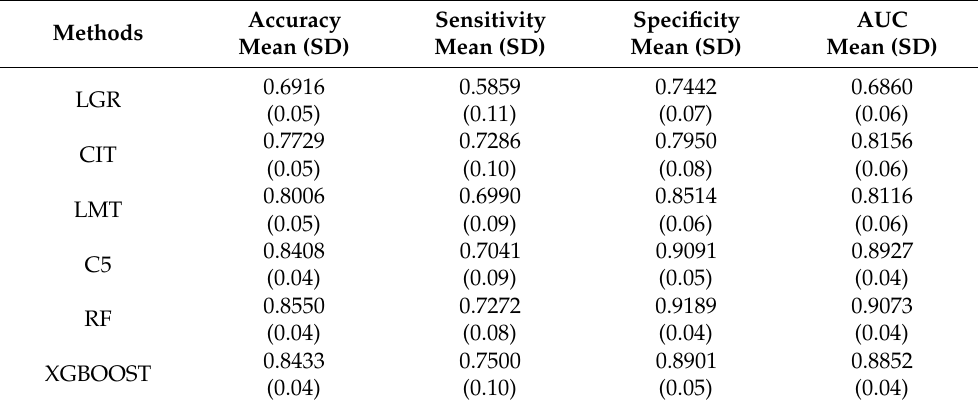
Table 3. Model performance of all methods for early glaucoma eyes.